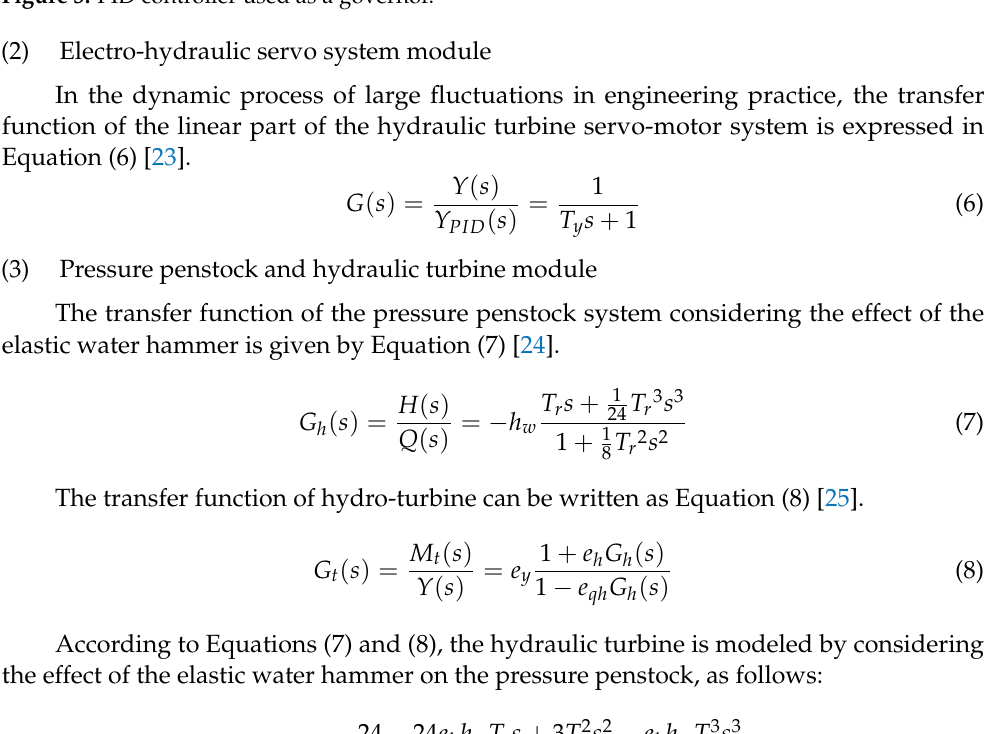
Figure 3. PID controller used as a governor.